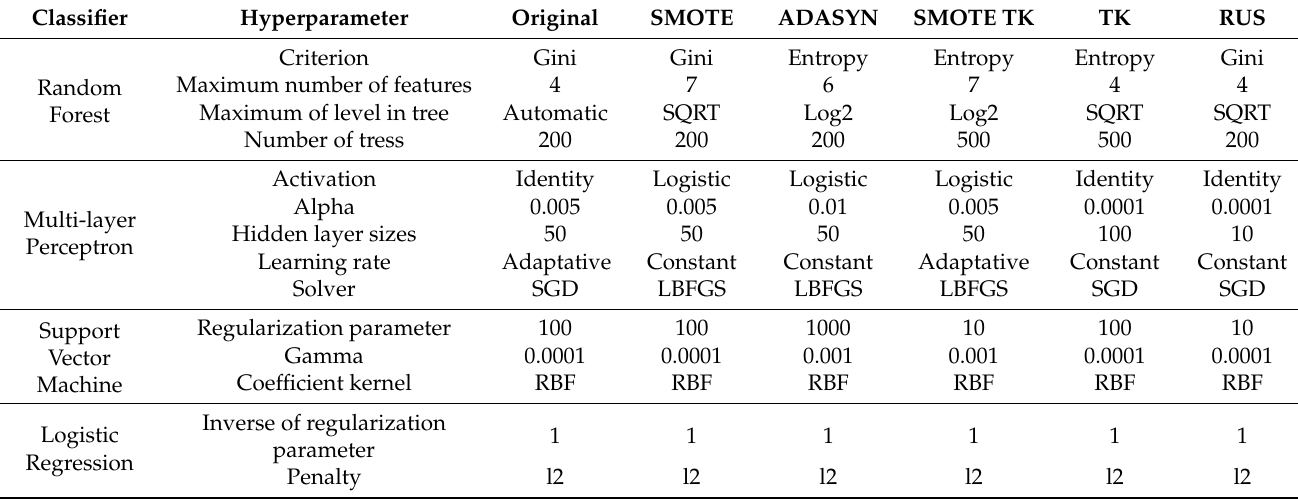
Table 2. Optimized hyperparameters per classifier and